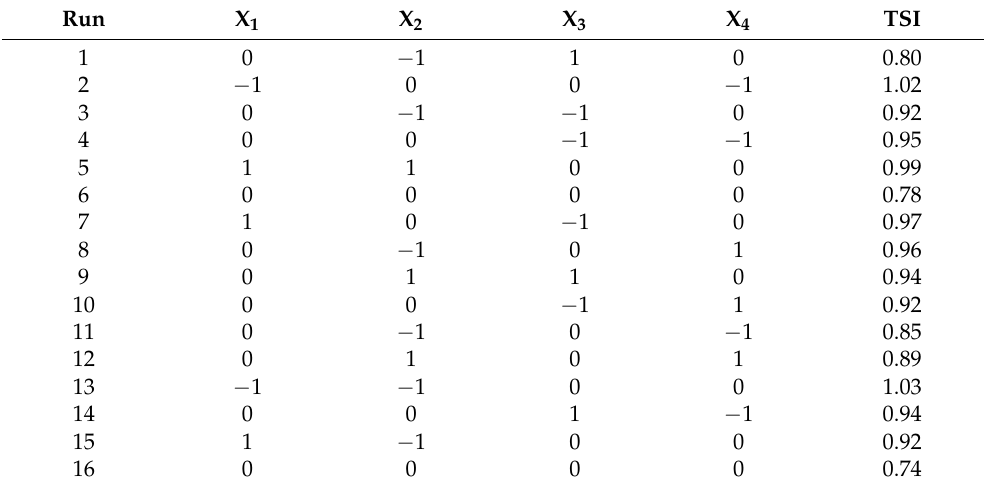
Table 1. Box–Behnken design for the